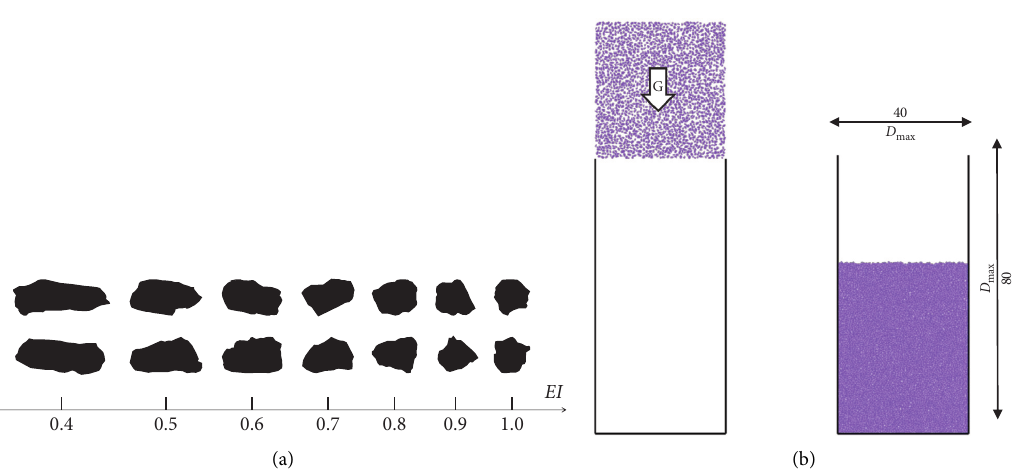
Figure 13: (a) GCS particles with different elongation; (b) stratified gravity deposition model. Table 2: Particle number and model parameters. Parameter